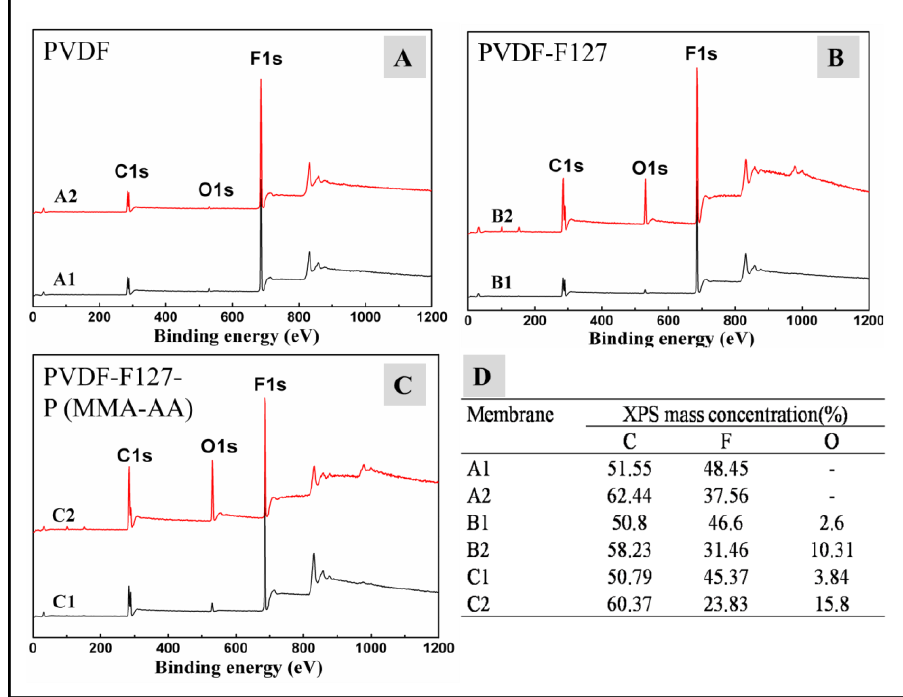
Figure 4. The XPS wide scan spectra of ( A ) PVDF; ( B ) PVDF-F127; ( C ) PVDF-F127-P (MMA-AA): (A1, B1, C1) membranes before heating treatment; (A2, B2, C2) membranes after heating treatment, respectively. ( D ) Surface element and composition of membranes.